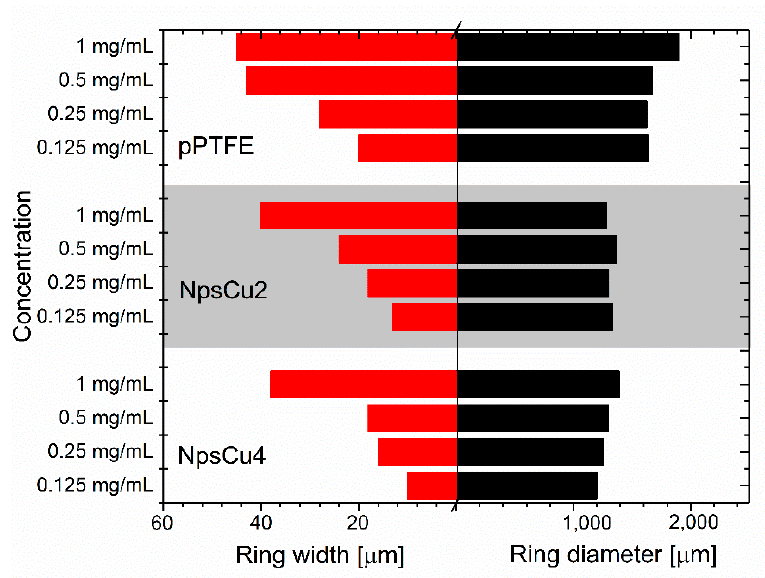
Figure 5. Lateral widths and diameters of the rings formed after the DPPC liposome suspension evaporation.